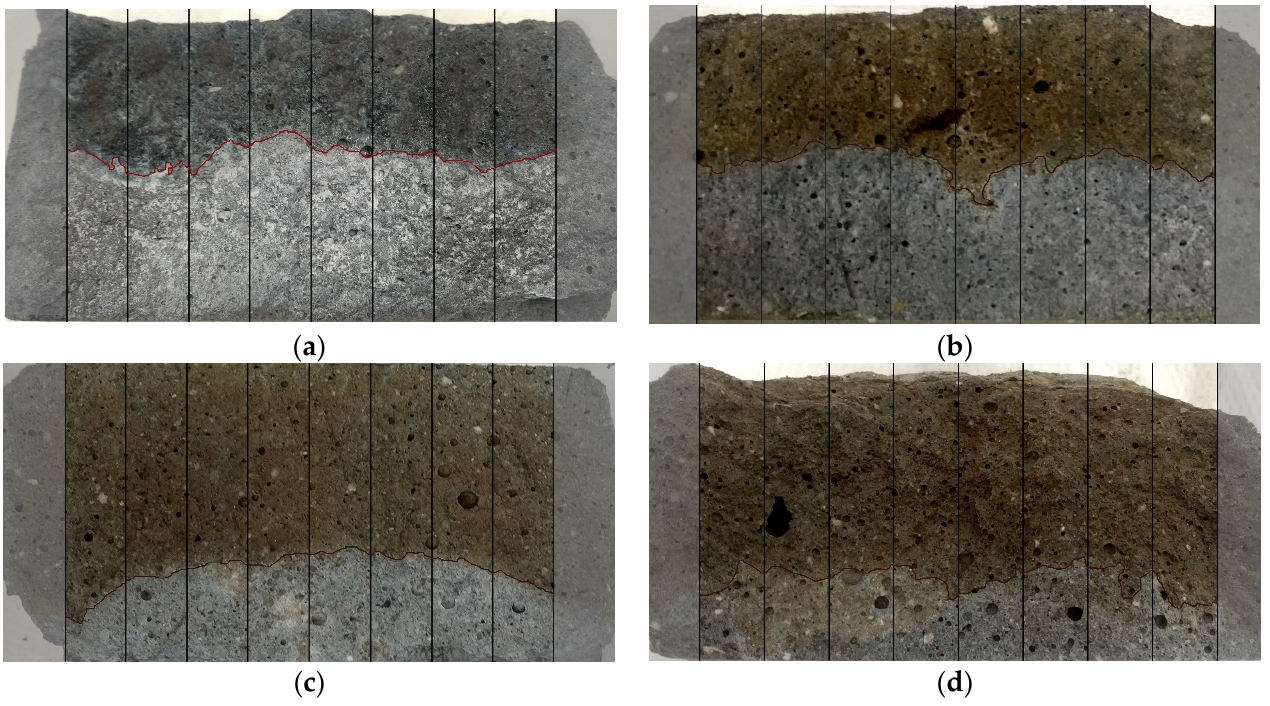
Figure 9. Specimens split for chloride penetration depth measurement after 6 h at 10 V: ( a ) AAM0 x d = 26.80 mm; ( b ) AAM10 x d = 25.03 mm; ( c ) AAM30 x d = 17.75 mm; ( d ) AAM50 x d = 13.46 mm.